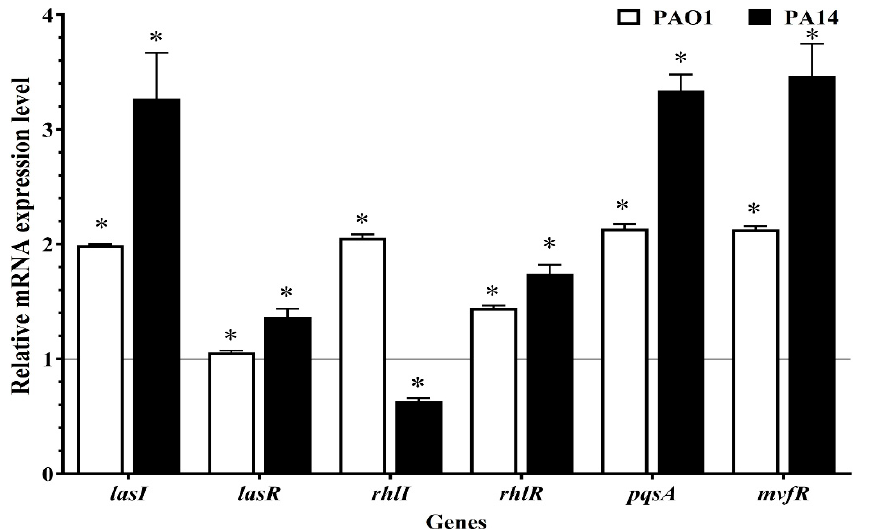
Figure 4. Relative expression of quorum-sensing regulatory genes in Pseudomonas aeruginosa treated with bio-AgNPs. The mean relative gene expression was normalized to that of the reference gene proC . * p <